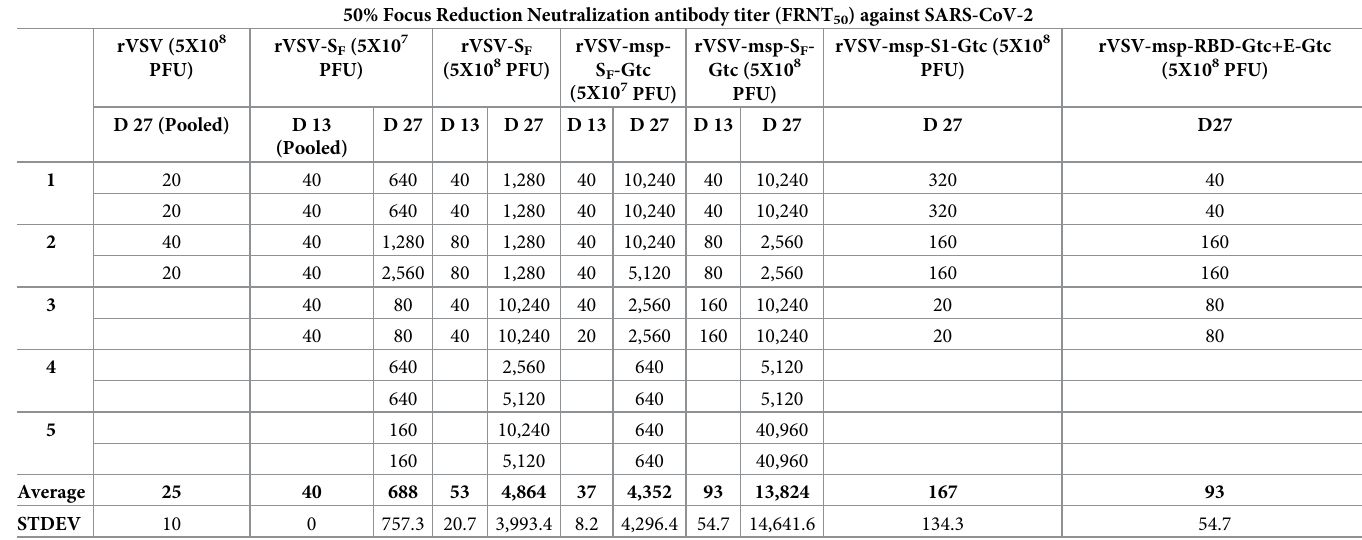
Table 1. Titration of Neutralizing Antibodies against SARS-CoV-2 in Mice after Prime-Boost Vaccination with